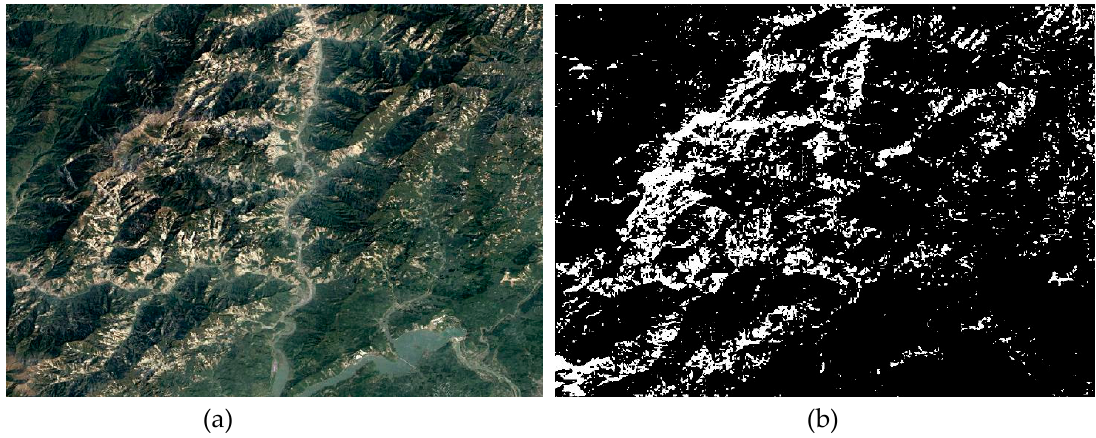
Figure 1. Example of a raw image and potential landslide extracted based on a raw image: ( a ) raw image; ( b ) potential landslide extracted image.